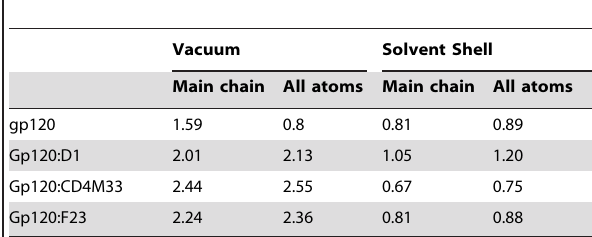
Table 2. The RMSD between minimized and crystal structures of